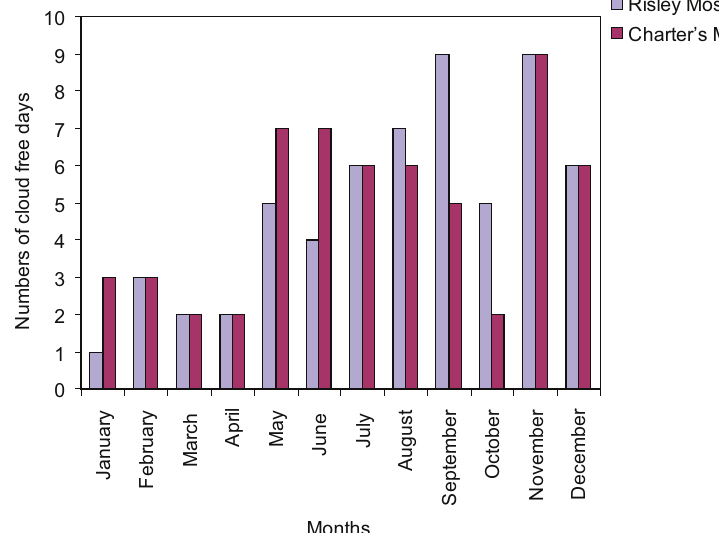
Fig. 8. Frequency of cloud-free days in Risley Moss and Charter’s Moss